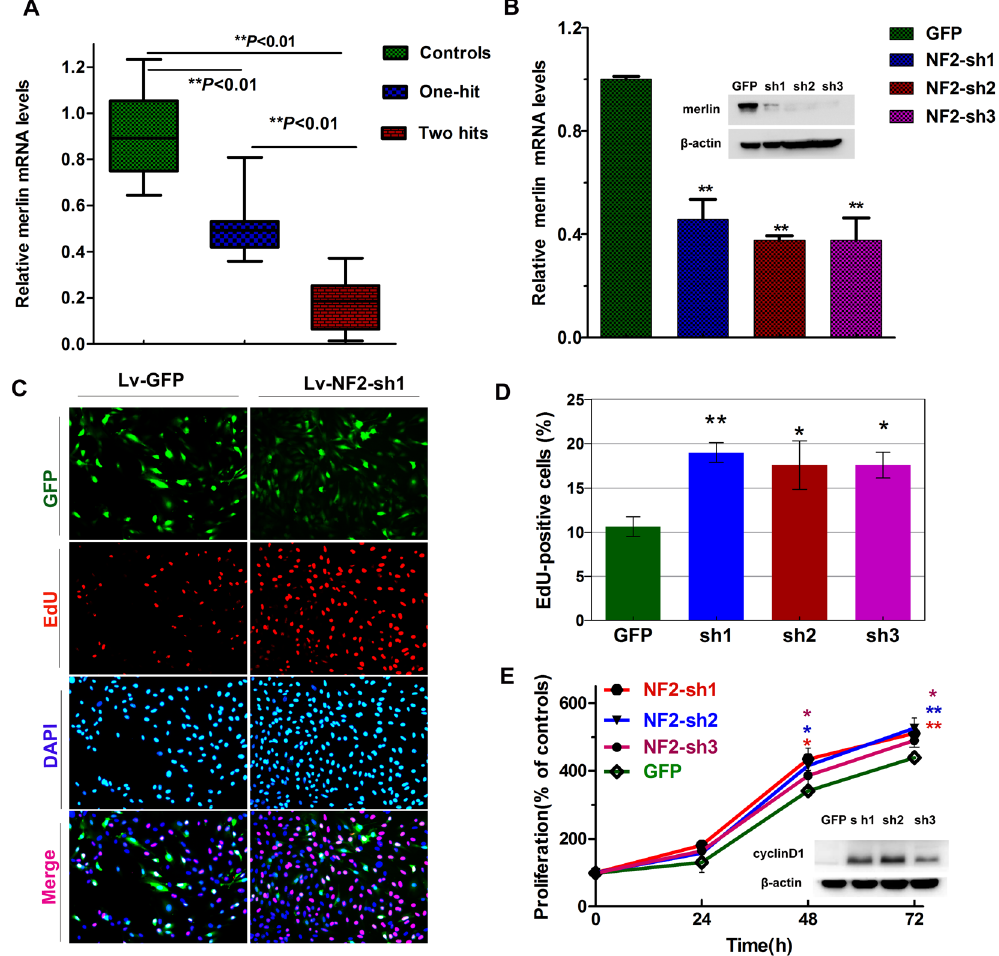
Figure 4. NF2 gene silencing caused increased tumour cell proliferation. (A) The qRT-PCR analysis was carried out to assess the expression level of merlin in 10 cases of ‘two-hits’ tumours, 10 cases of ‘one-hit’ tumours, and 10 vestibular nerves. The details were shown in Supplementary Table S2. ( B ) The expression of merlin in response to NF2 knockdowns was measured by qRT-PCR and Western Blotting analyses. All qRT-PCR reactions were performed in duplicate. (C) Representative images of EdU labelling and DAPI staining were captured under the fluorescence microscope at a magnification of × 200. (D) The quantification of EdU incorporating-cells was calculated as follows: EdU-positive cell numbers (red dots)/total numbers (DAPI, blue dots) × 100%. At least three random images were taken from each well. (E) The effects of merlin knockdown on cell proliferation were determined by CCK-8 assays. GFP: nonsense shRNA; sh: shRNA. Data were represented as the mean ± SEM (Supplementary Table S3). * p < 0.05 and ** p < 0.01. Full-length gels are presented in Supplementary Figure